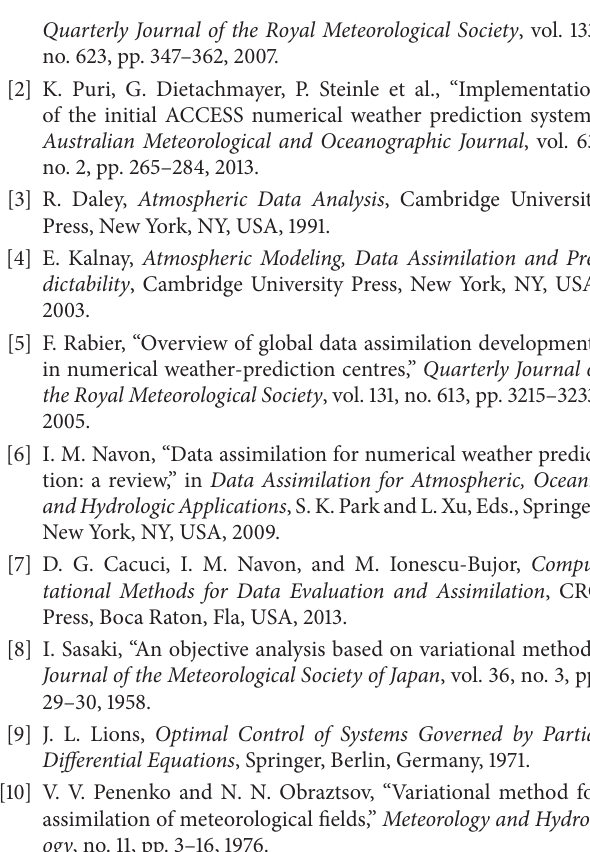
In general, the procedure for solving a sensitivity analysis problem represents the following set of